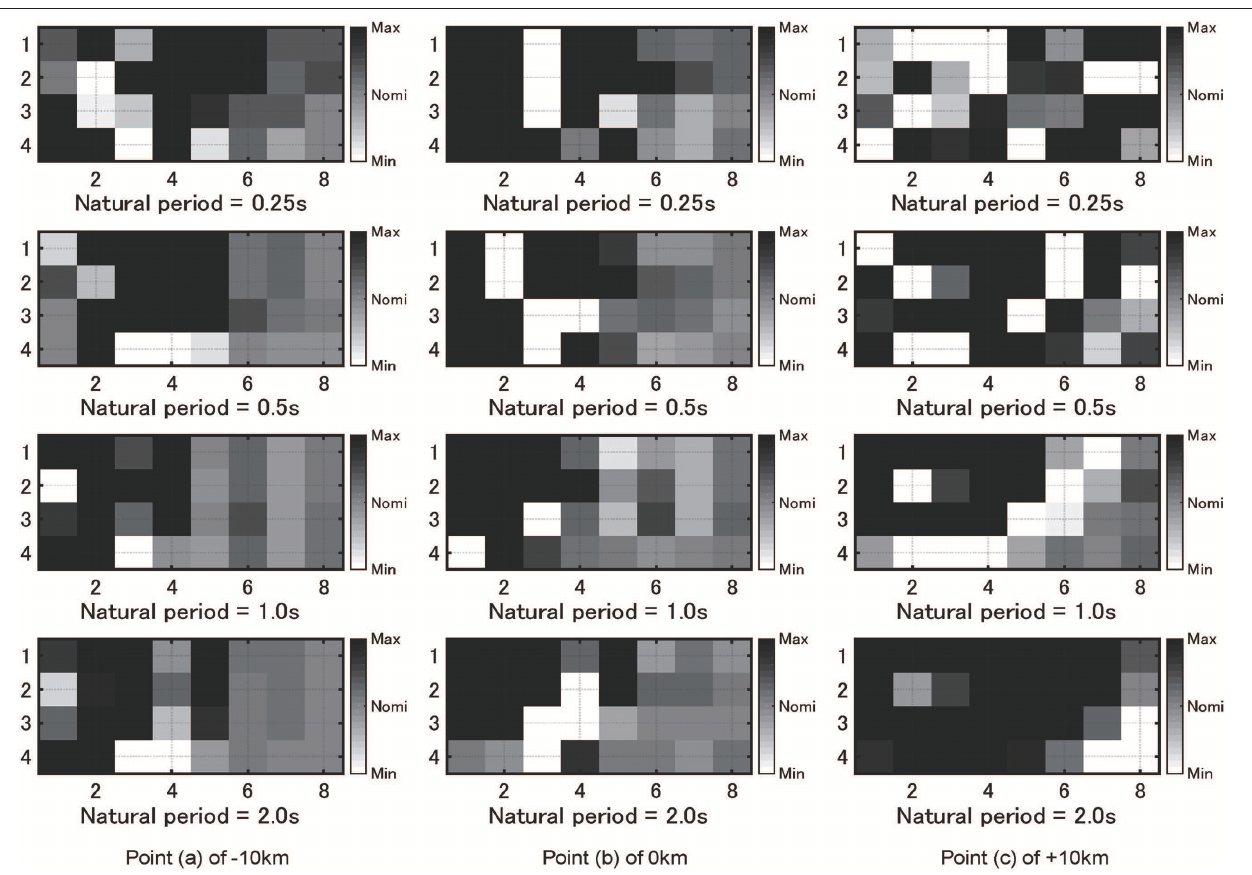
FIGURE 10 | Critical fault slip distribution of four MDOF models with different number of stories ( T 1 = 0.25 s , 0.5 s , 1.0 s , 2.0 s ) at three points (Straight lowest natural mode).